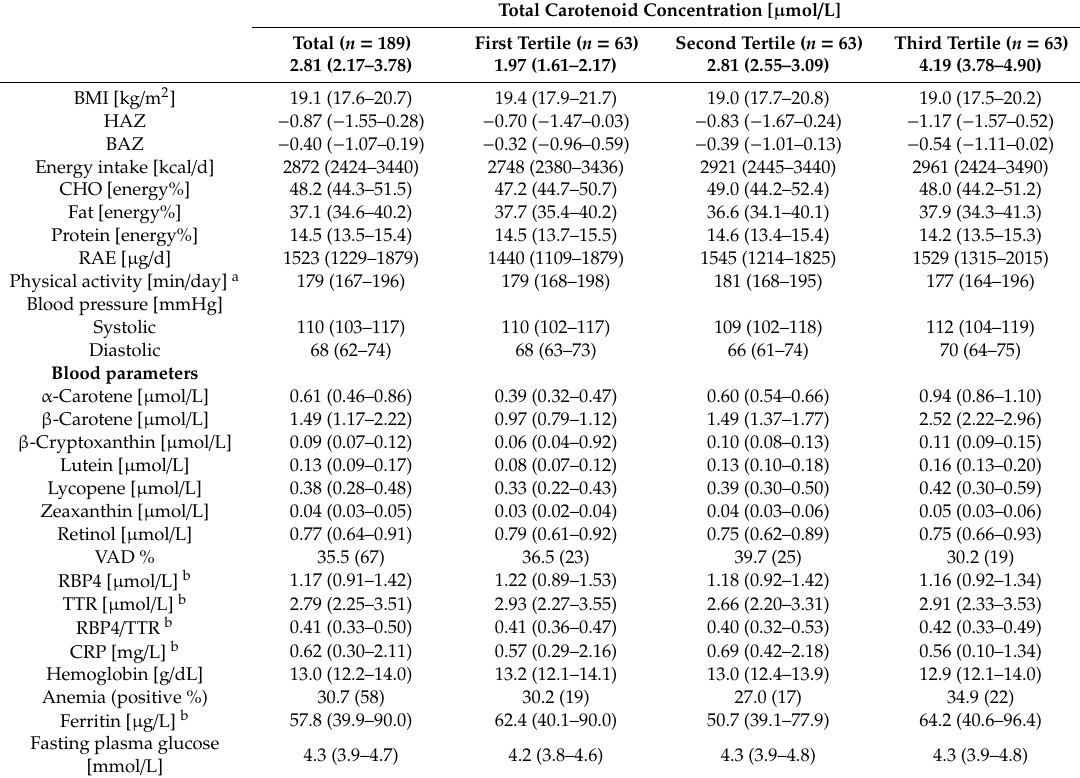
Table 2. Anthropometric and clinical characteristics across tertiles of plasma total carotenoid